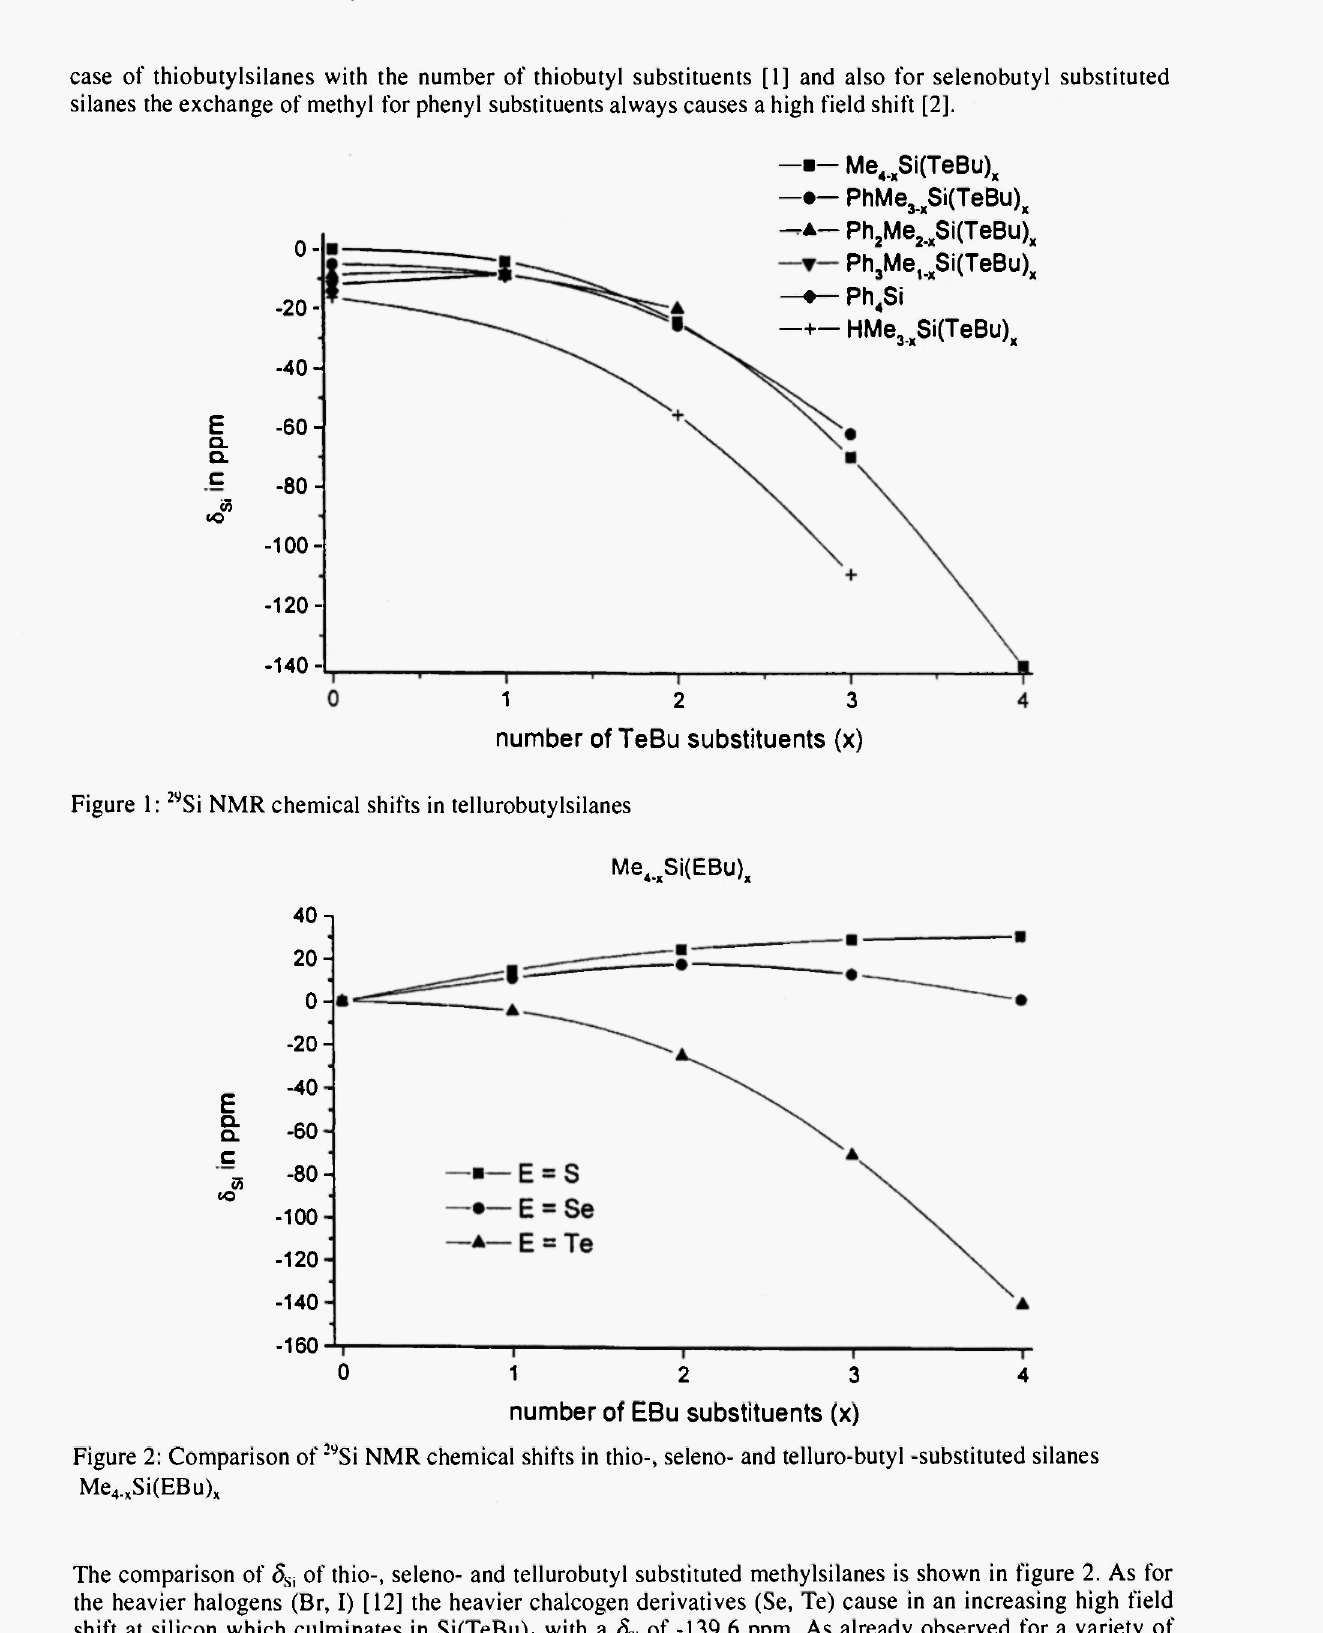
Figure 1: w Si NMR chemical shifts in tellurobutylsilanes